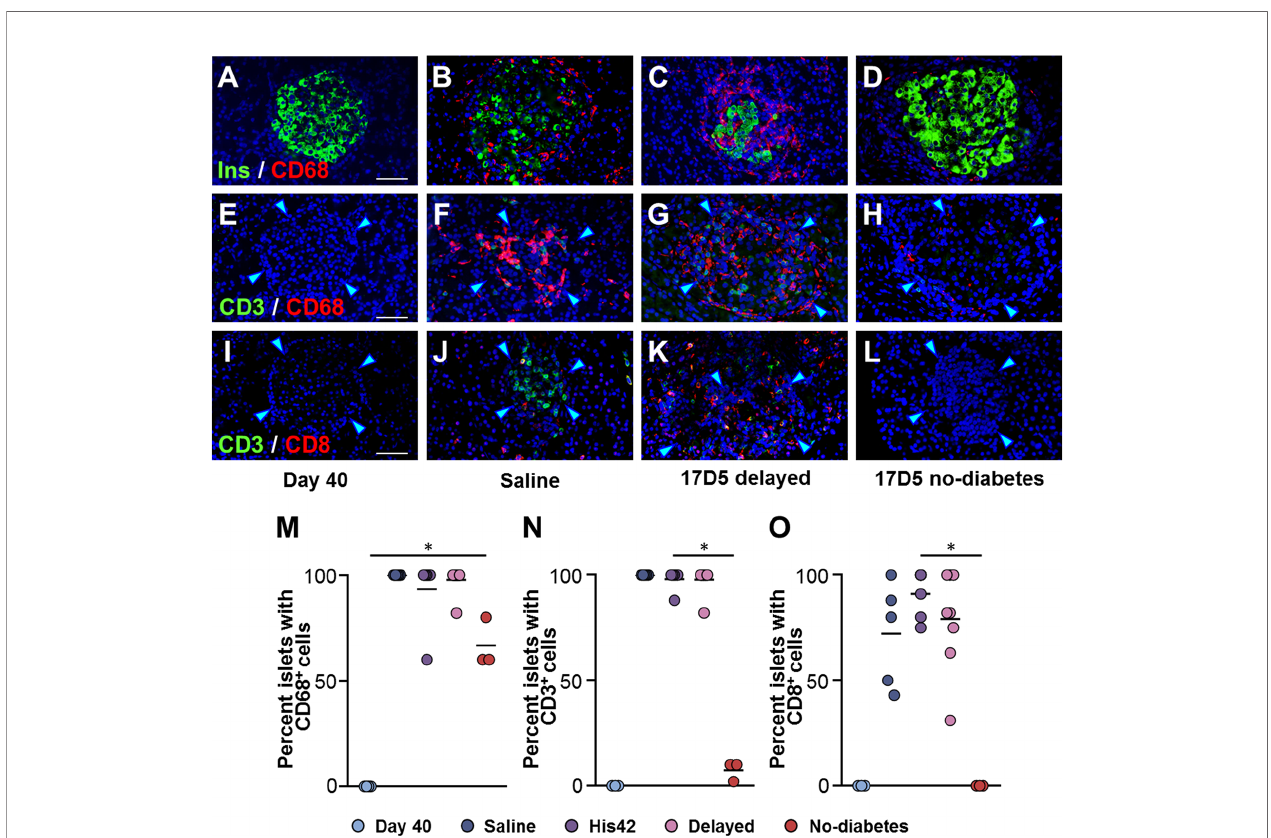
FIGURE 3 | Occurrence of insulitic macrophages and lymphocytic cells in DR Lyp/Lyp rats. (A – D) Immunohistochemistry for insulin (Ins, green) and the macrophage marker CD68 (red) in the indicated groups. Immunostaining for the T cell marker CD3 (green) and either CD68 (E – H) , or the cytotoxic T cell marker CD8 (I – L) . Scale bars, 50 µm. To avoid redundancy, images from His42-treated rats are not shown. The arrowheads point to the islet border. Prevalence of islets with insulitic CD68 (M) , CD3 (N) , and CD8 (O) cells. Each circle denotes an individual rat; dark slate blue, saline (n = 5); purple, His42 (n = 6); pink, 17D5 delayed (n = 8); red, 17D5 no- diabetes (n = 3); light slate blue, 40 day old (n = 3). Data are mean values of measurements obtained for each rat. The solid horizontal lines indicate the mean of the measurements in each group. * P < 0.05, 17D5 no-diabetes vs saline, His42, 17D5 delayed, or day 40; Mann-Whitney U